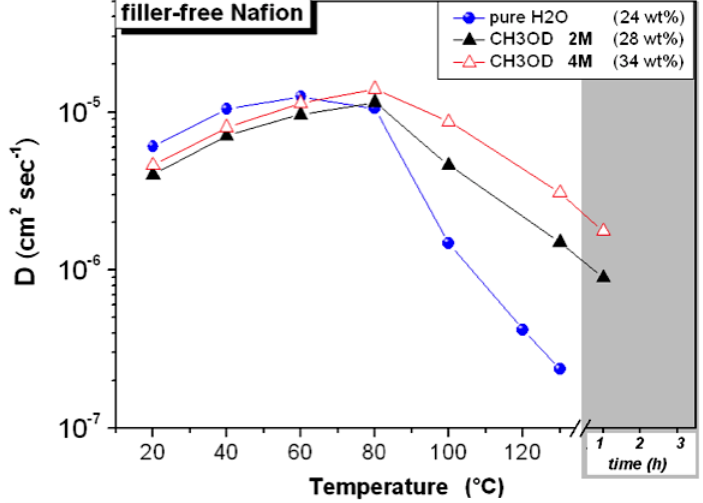
Figure 2. Self-diffusion coefficients of water and methanol (2 M and 4 M solution concentration) confined in filler-free Nafion membranes from 20 °C up to 130 °C; the data collected at 130 °C after 1 h is also plotted. In the legend, the water and solution uptakes are